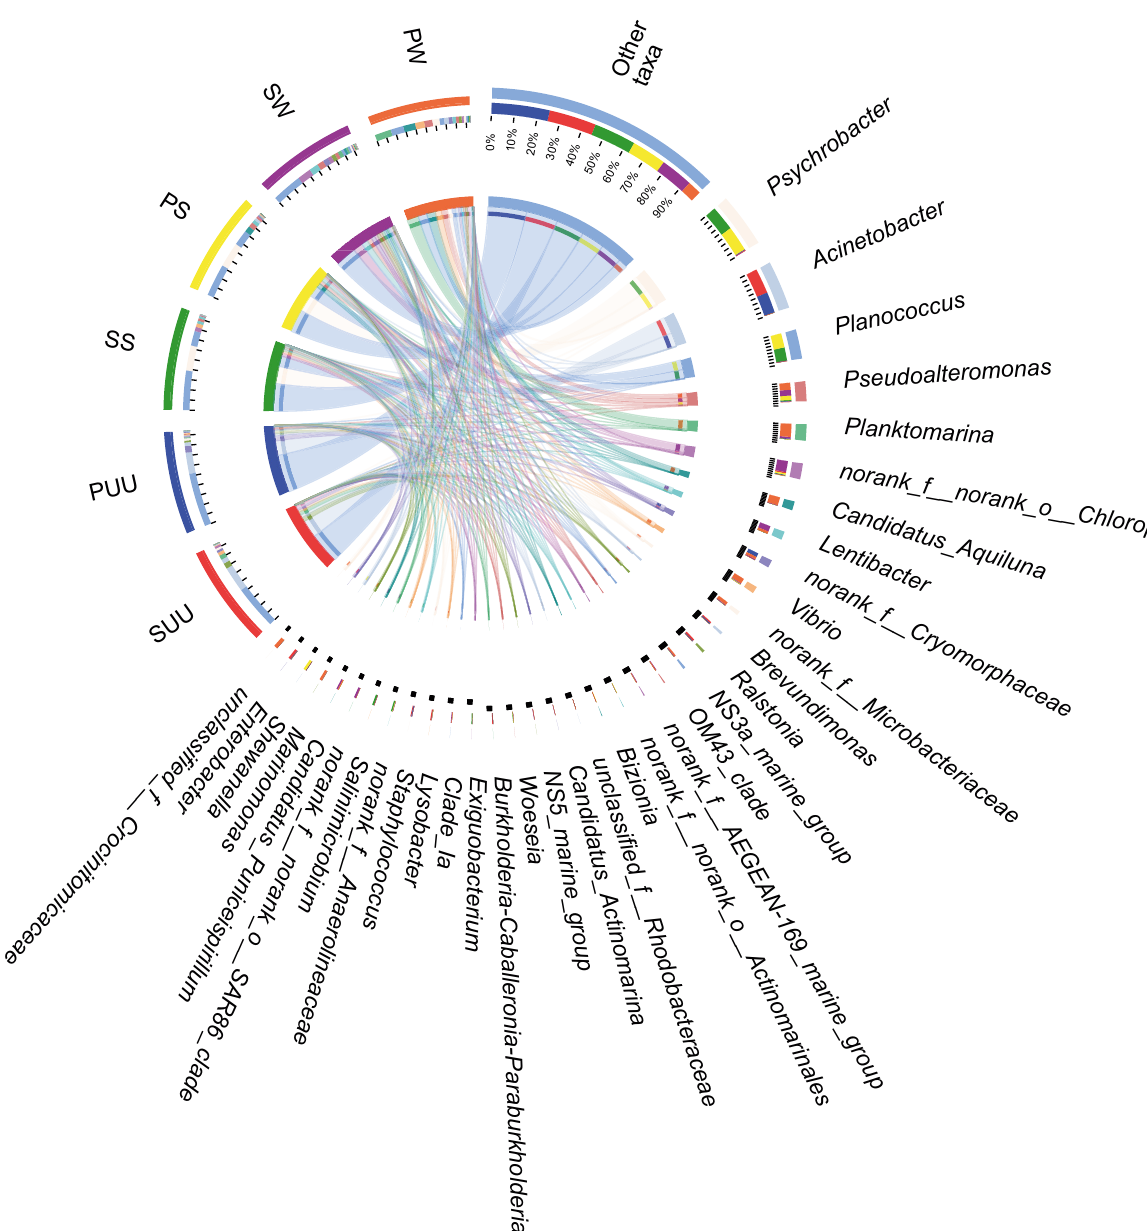
Fig. 3. Circos diagram of the relationship between samples and genera. The upper-left part of the circle shows the composition of genera in the samples (abbreviations as in Table 1); the colours of the outer band represent the samples, the colours of the inner band represent the genera, with the length of the colour sections indicating their relative abundances. The remaining part of the circle shows the samples in which genera occur; the outer band represents genera (each is given its own colour), the inner band represents different samples, with the length of the colour sections indicating their relative occurrences. The black tick marks provide a scale of proportion in 10% intervals. The central circle shows connections between genera and the samples in which they Puniceispirillum , Pseudoalteromonas , Lentibacter ,